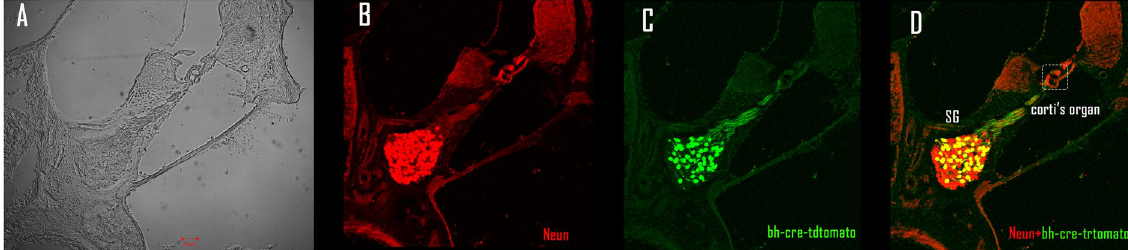
Figure 4. Images identifying SGN specific expression of Bhlhb5-cre. A cochlear cross section slide was observed (unstained) under the light microscope ( A ), and then stained with Neun ( B ), and against tdTomato ( C ) to show the Cre. ( D ) Merged images of ( B and C ).